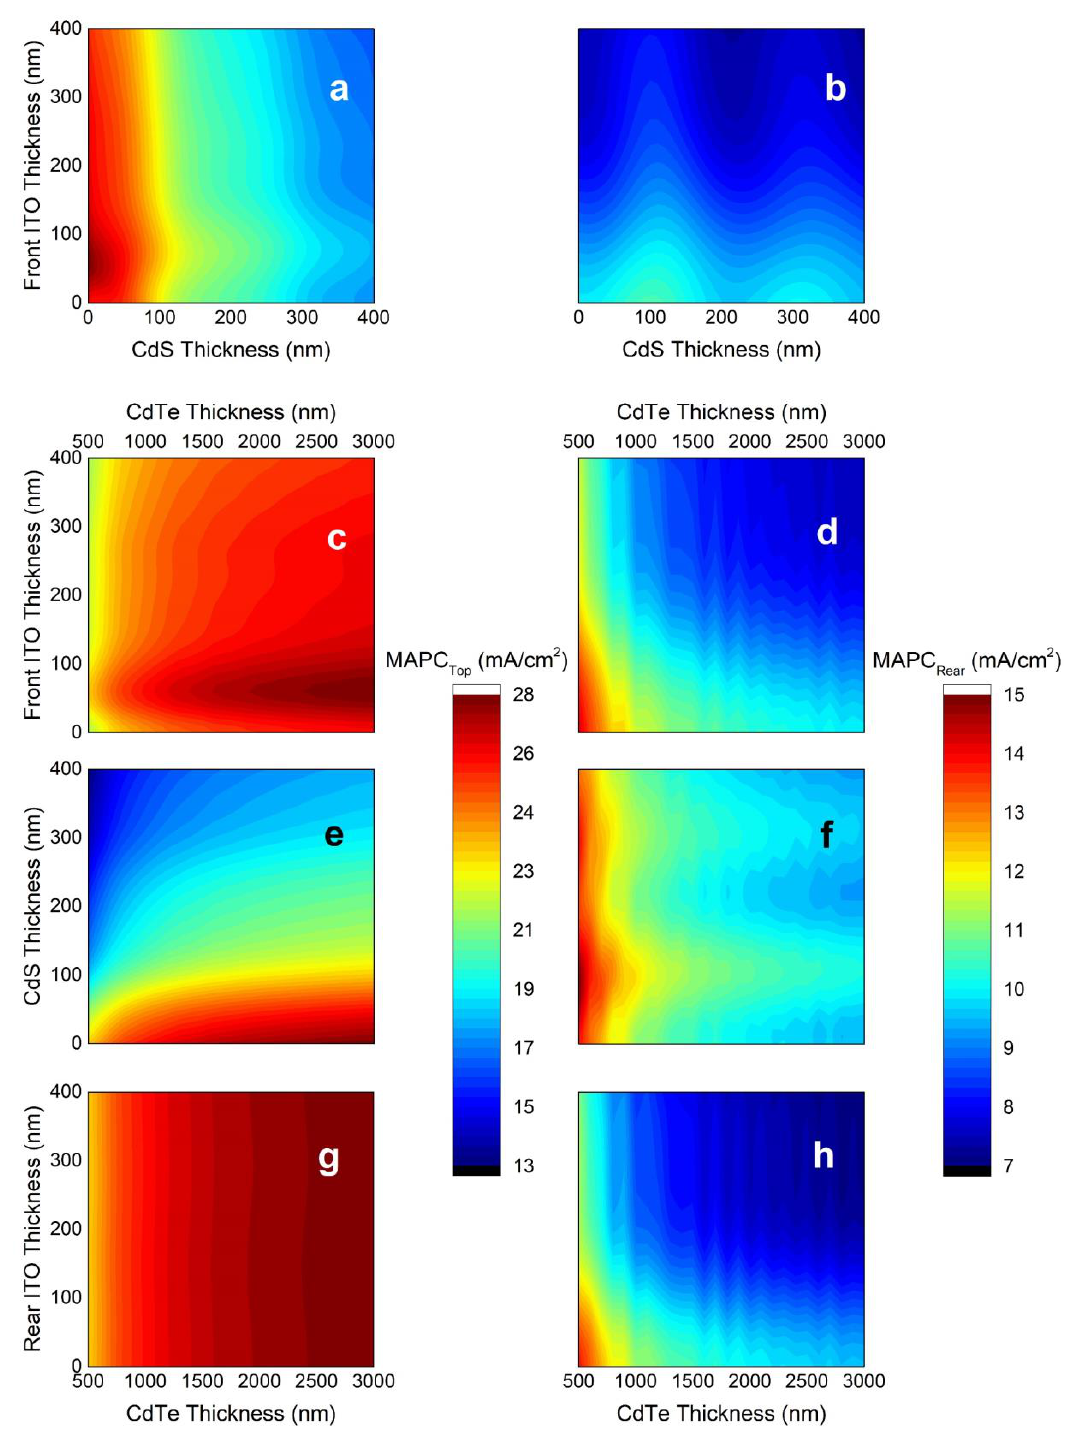
Figure 3 Figure 3. The maximum achievable photocurrent (MAPC) of CdTe and IBC Si cells for various front indium-tin-oxide (ITO) and CdS thicknesses for a constant CdTe thickness of 3000 nm, assuming no rear ITO layer is present ( a , b ); for various front ITO and CdTe thicknesses, assuming no CdS and rear ITO layers are present ( c , d ); for various CdS and CdTe thicknesses, assuming a front ITO layer thickness of 55 nm and no rear ITO is present ( e , f ); and for various rear ITO and CdTe thicknesses, assuming a front ITO layer thickness of 55 nm and no CdS layer is present ( g , h ),